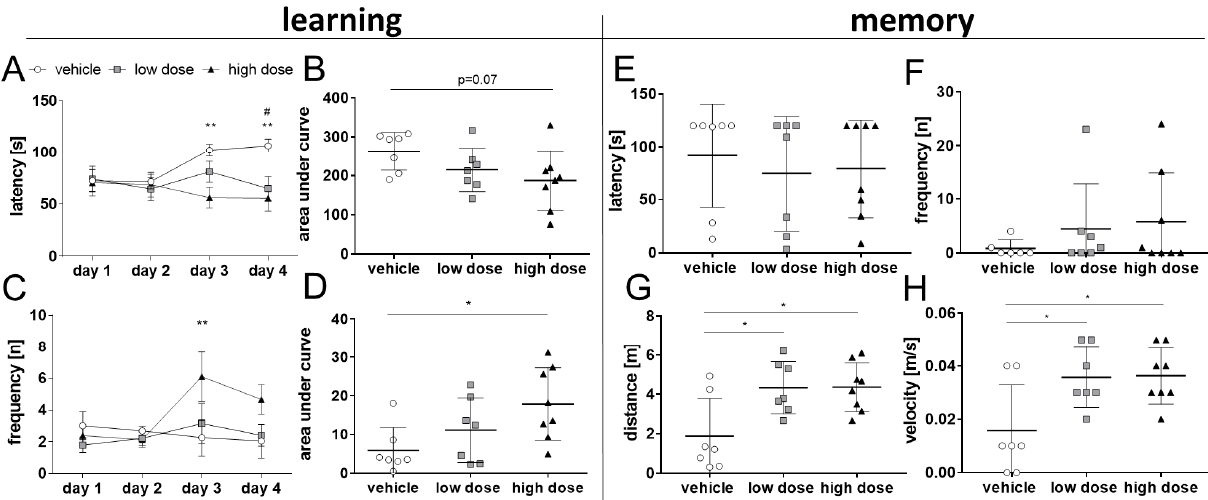
Figure 6. Learning behavior in the Barnes maze (BM). Mice were tested in the BM ( n = 7–8/group). ( A ) During the learning phase of the test, mice treated with vehicle performed worse than mice treated with the high dose of MTK. Mice treated with the high dose performed significantly better than the vehicle group on days 3 and 4. ( B ) Mean area under curve (AUC) of latency on days 3–4 of the BM shows a trend to a dose-dependent decrease ( p = 0.07). ( C ) Mice from the high-dose treatment group had higher frequencies of target contact, which was significant on day 3 between high dose- and vehicle-treated groups. ( D ) AUC of frequency on days 3–4 of the BM shows a dose-dependent increase, which is significant between vehicle and high-dose treatment groups. ( E , F ) During the memory test, no significant difference between groups was detected in the parameters of latency and frequency. However, mice had huge motivational problems regardless of their group. ( G , H ) Mice treated with MTK did show significant longer distances and higher velocities compared to vehicle-treated animals. Data are shown as mean +/ − SEM. Two-way ANOVA ( A , C ) or one-way ANOVA ( B , D , E – H ) was performed with Tukey ´ s post hoc test. P -values of p < 0.0001 and p < 0.001 were considered extremely significant (**** or ***),